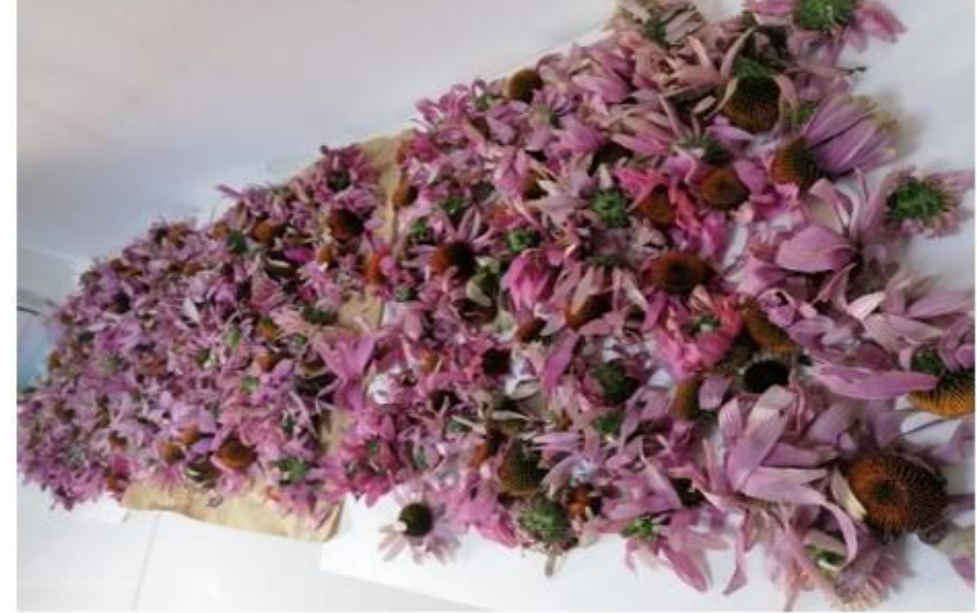
Figure 1. E. purpurea flowers used in the experiments.